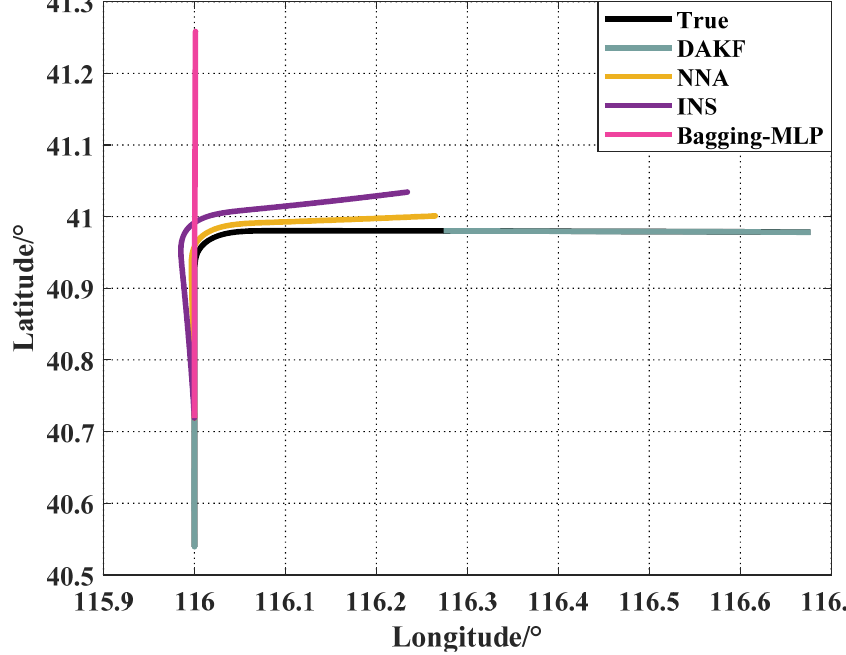
Figure 8. Comparison results between NNA and MLP-based Bagging method.